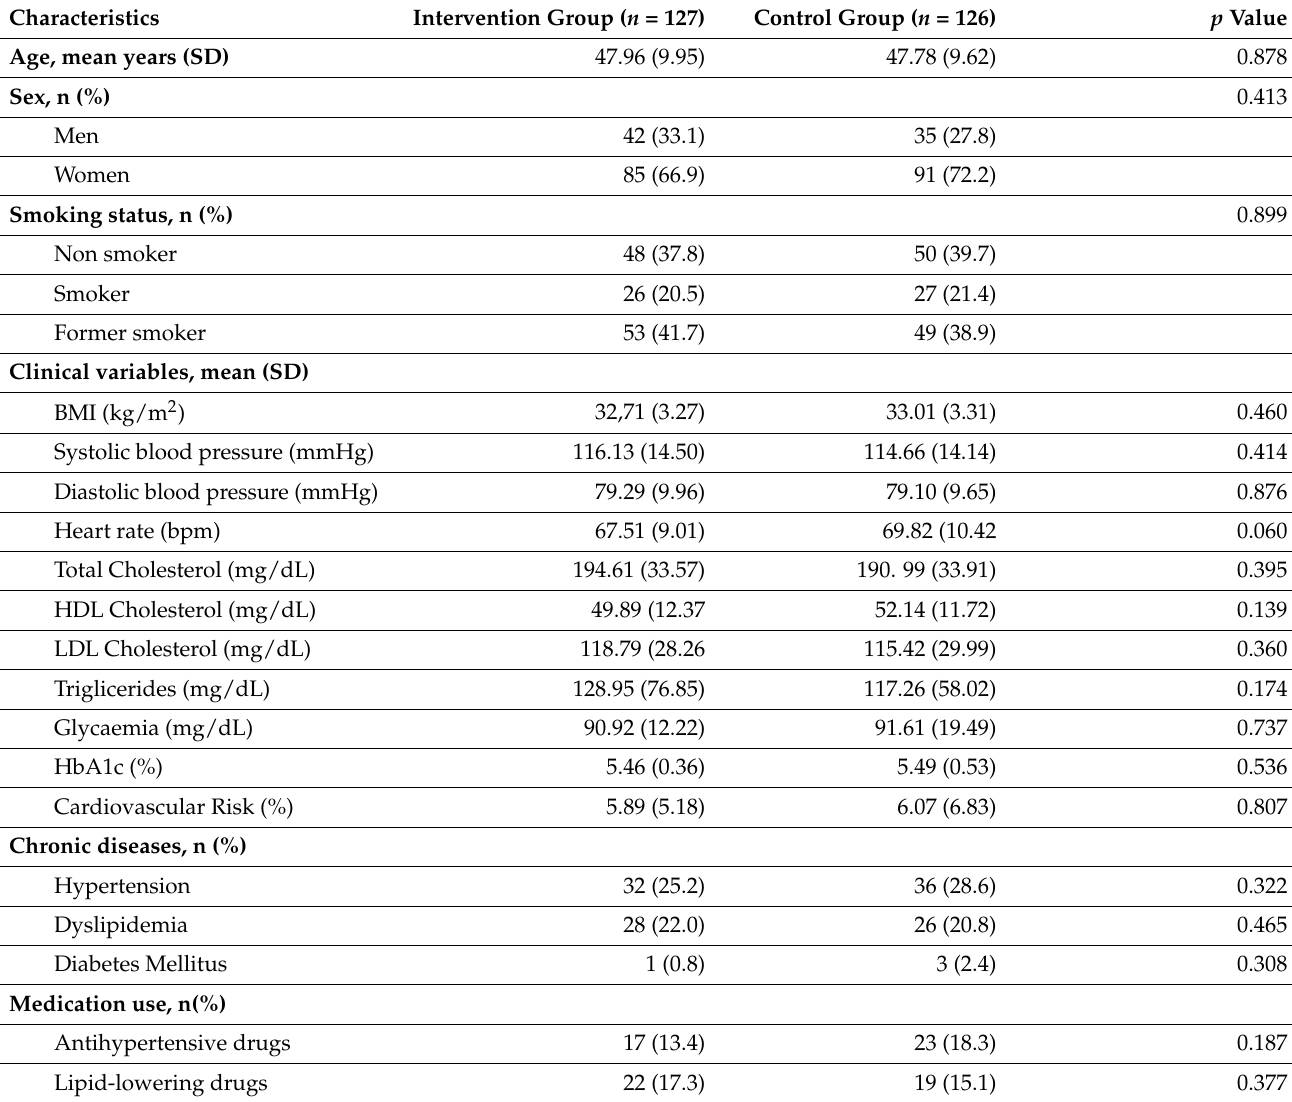
Table 1. Baseline characteristics of study